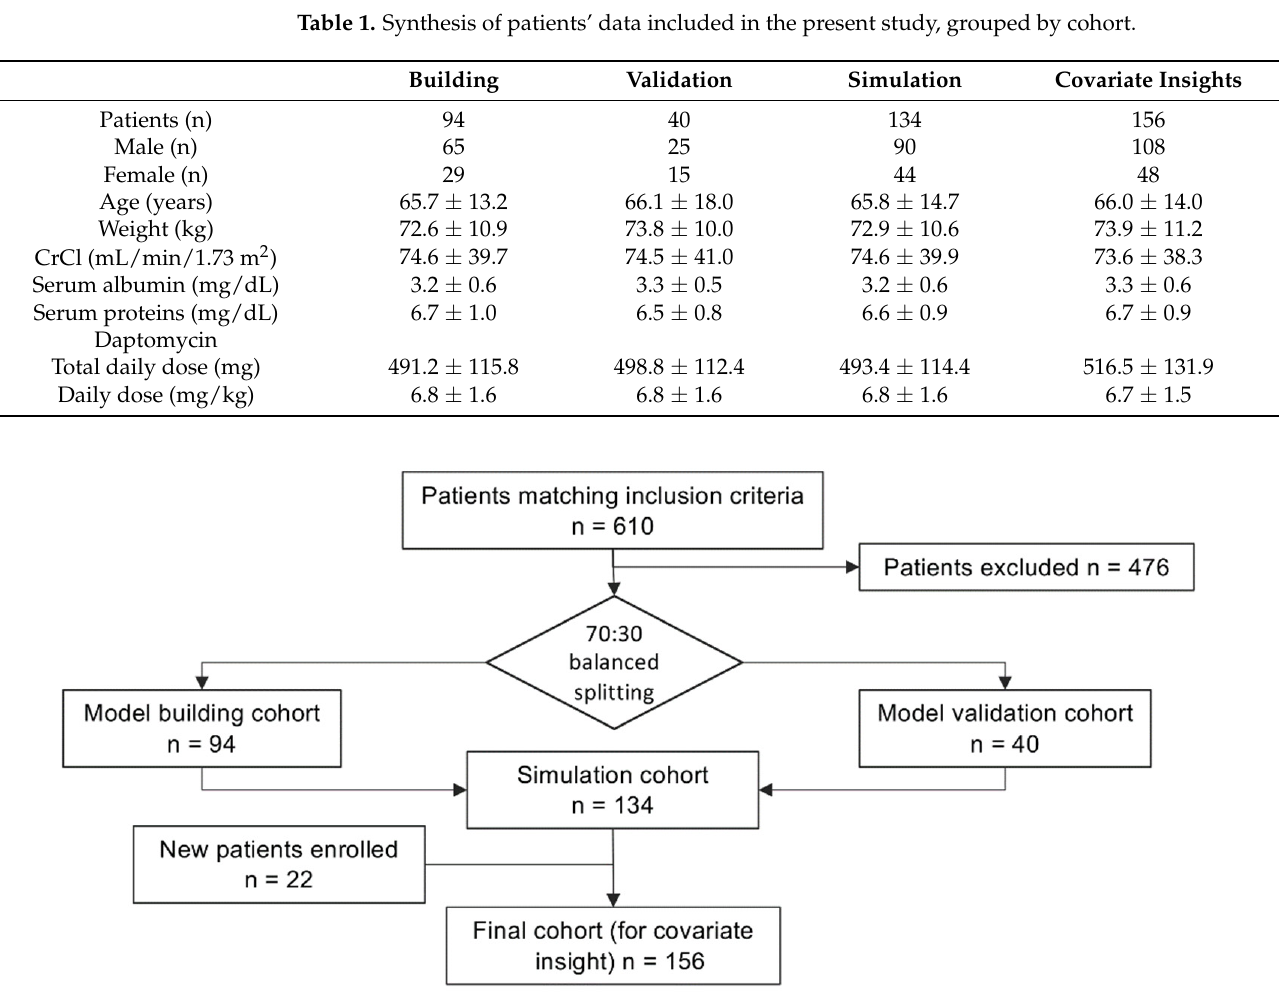
Table 1. Synthesis of patients’ data included in the present study, grouped by cohort.